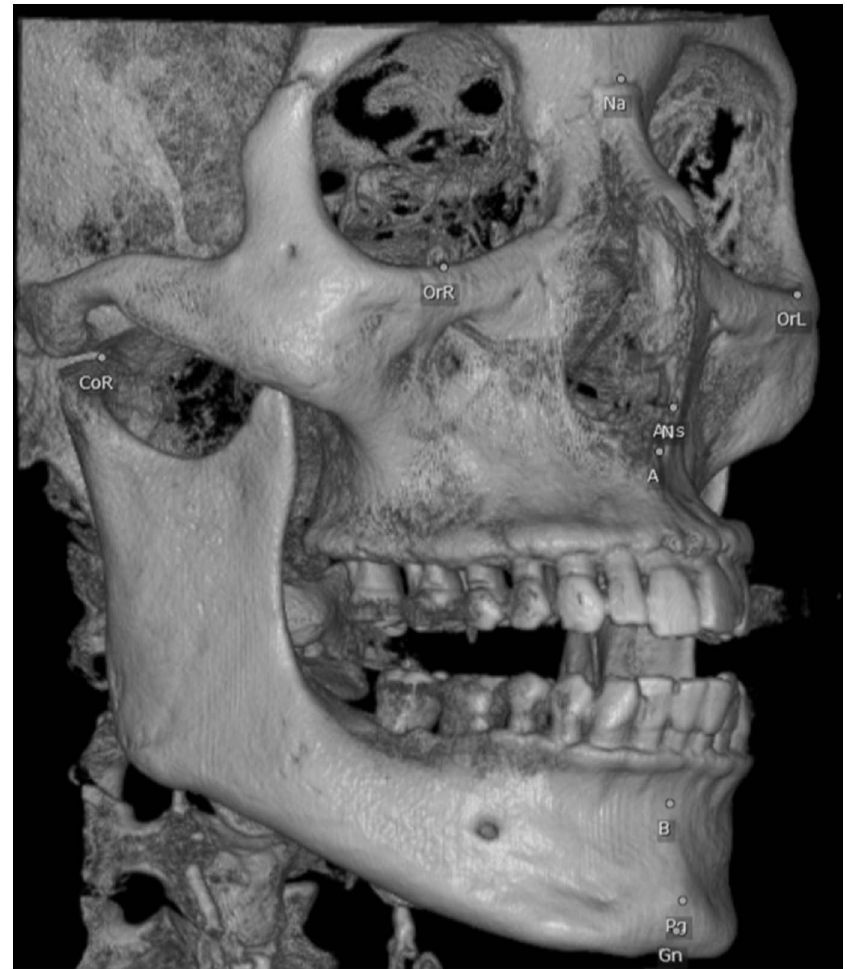
Figure 1. Landmarks before reorientation.